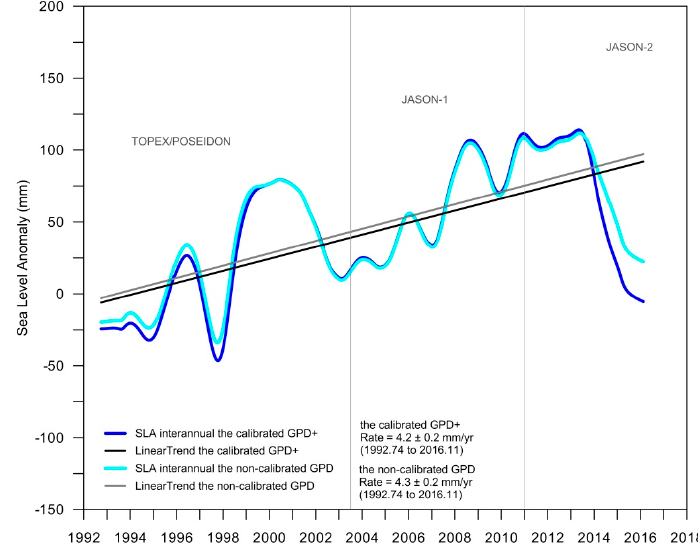
Figure 23. Inter-annual mean sea level variation in the Indonesian seas using the calibrated GPD+ (blue) and corresponding linear trend (black). Inter-annual mean sea level variation in the Indonesian seas using the non-calibrated GPD (cyan) and corresponding linear trend (grey).